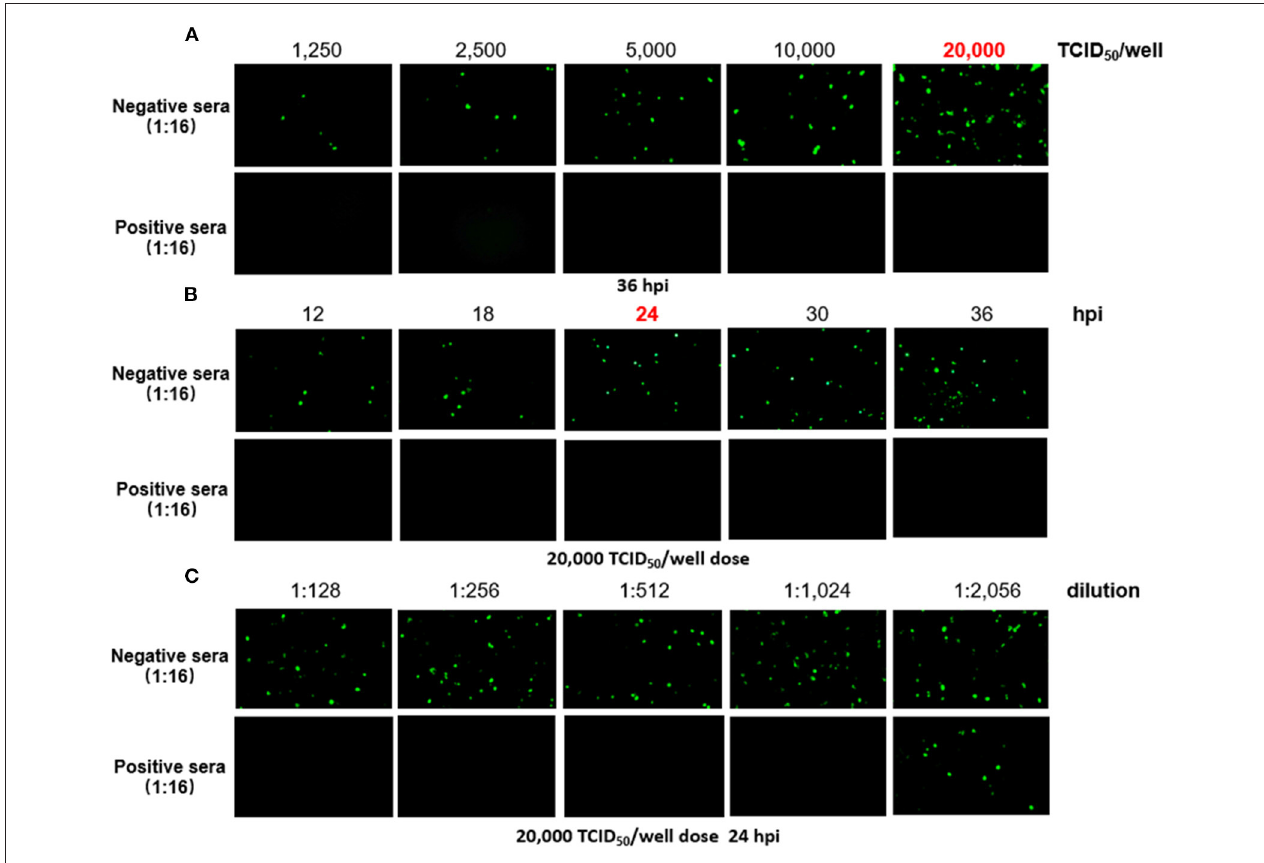
FIGURE 1 | Determination of the VNT procedure. In the novel VNT, the optimal dose of FA4-EGFP (A) and detection time point (B) were determined by reference positive and negative serum. The neutralizing activity (NT) of the positive serum, but not negative serum, could be efficiently titrated at the final dose of 20,000 TCID 50 /well of FA4-EGFP at 24 dpi (C)